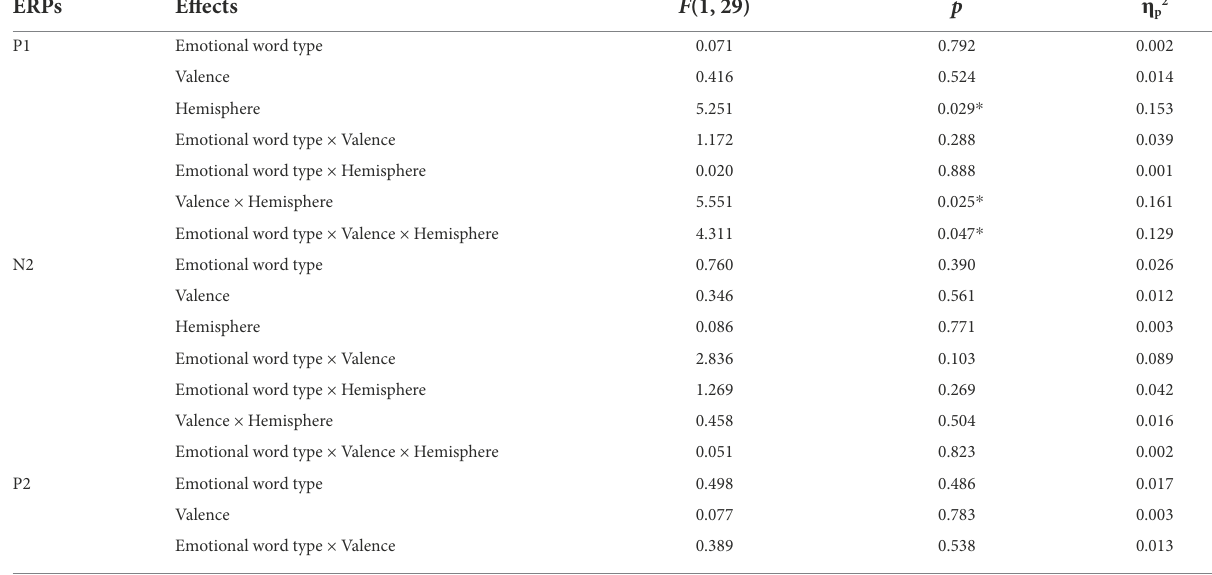
TABLE 4 The ERP results of the cue in the